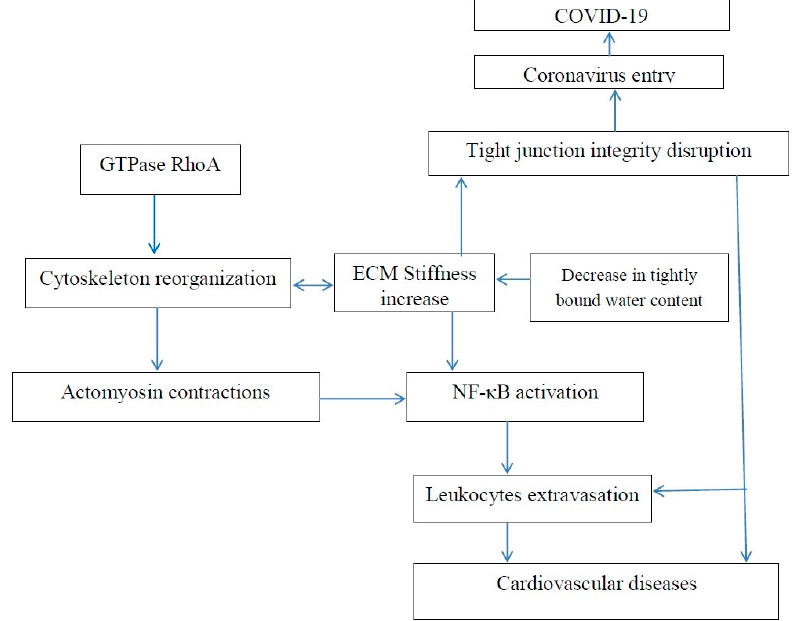
Figure 2. Increase in extracellular matrix sti ff ness results in both an increased risk of age-related cardiovascular disease and an increased risk of